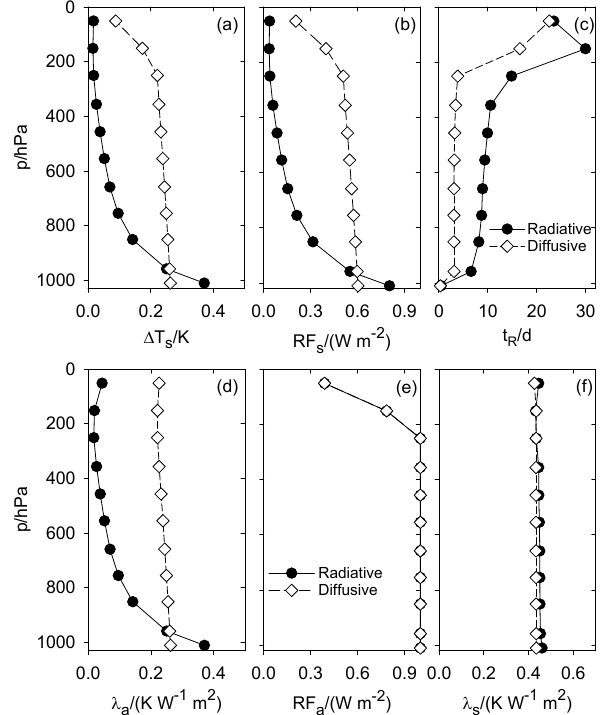
Figure 7. (a) Temperature change at the surface for layer heat- ing versus the layer pressure height. The ghost forcing corresponds to an RF i of 1Wm − 2 at TOA. Black symbols with full line: ra- diative case; white symbols with dashed line: radiative-diffusive case. (b) Corresponding RF s values for fixed T s . (c) Relaxation timescales t R = (cid:49)T layer /H . (d) Climate sensitivity parameter λ a = (cid:49)T s / RF a based on stratosphere-adjusted RF a ; (e) RF a ; (f) climate sensitivity parameter λ s = (cid:49)T s / RF s based on effective RF s